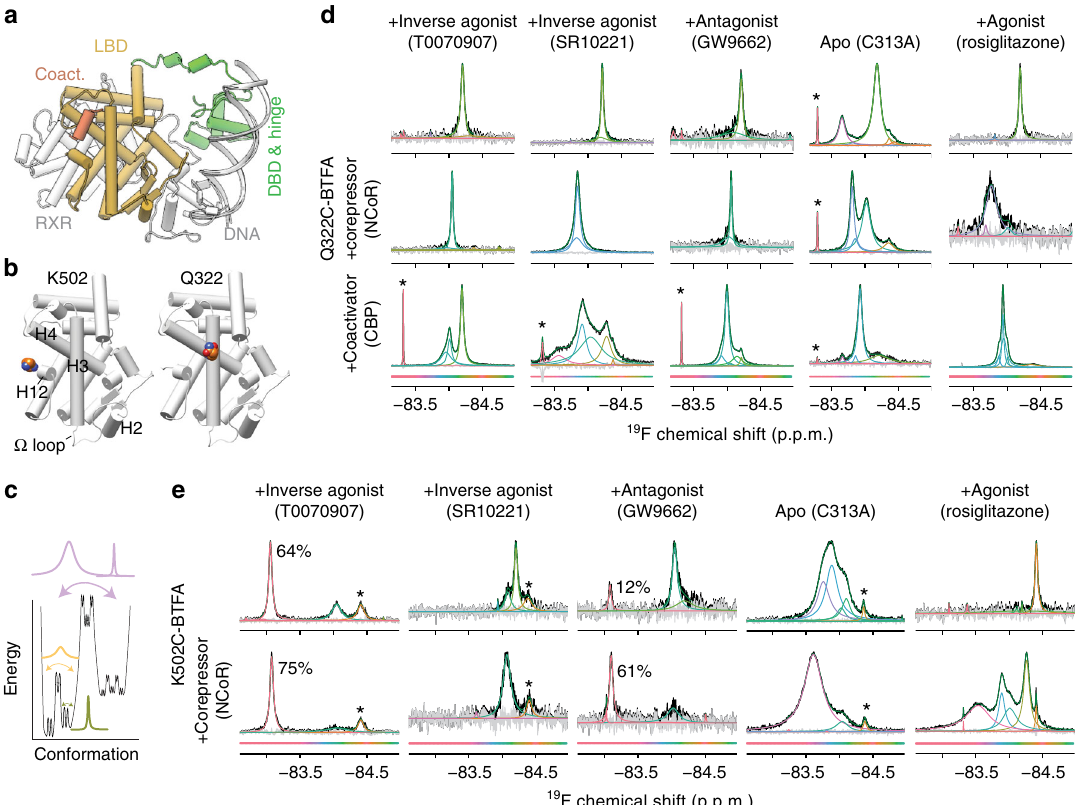
19 F chemical shift (p.p.m.) Fig. 1 NMR indicates that the Helix 3 and helix 12 structural ensembles are diverse and ligand dependent. a Overall architecture of a nuclear receptor signaling complex (PDB code 3DZY). The DNA-binding domain (DBD), hinge region, and ligand-binding domain (LBD) of PPAR γ are shown bound to a coactivator peptide (coact.) and DNA. The heterodimerization partner of PPAR γ is also shown (RXR). b Location of residues that were changed to cysteine and labeled with BTFA (colored spheres) on the PPAR γ LBD for the two variants used in panels ( d ) and ( e ). Helix 2, 3, 4, and 12 and the omega loop ( Ω loop) are indicated. c Illustration of the relationship between energy of a structural conformation, barrier height between conformations, and 19 F NMR spectra. Color denotes the exchange rate between conformations in the energy wells. Purple denotes slow exchange (e.g., ms – s lifetime), tan denotes intermediate exchange (e.g., μ s – ms lifetime), and olive denotes fast exchange (ps – ns lifetime). d , e 19 F NMR spectra of PPAR γ labeled on helix 3 (panel d ) and helix 12 (panel e ) with BTFA and bound to the indicated ligands. Individual deconvoluted peaks are colored according to chemical shift as indicated by the color bars below the spectra. The lower rows of spectra include a 2× molar ratio of CoRNR box peptides derived from the corepressor NCoR or the coactivator CREB-binding protein (CBP). The percentages in panel e refer to the portion of the spectral area found in the left peak. Asterisk denotes unfolded PPAR γ , free BTFA, or BTFA labeled contaminating protein 24